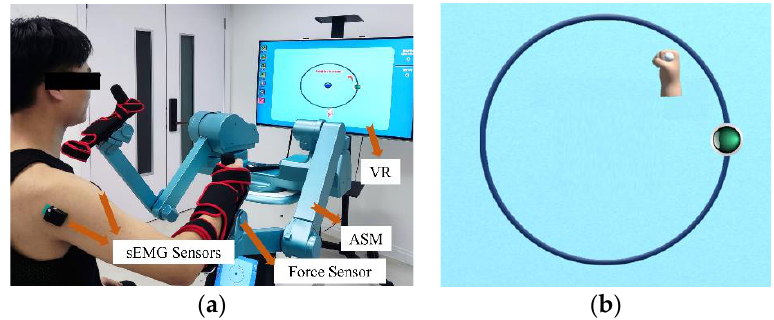
Figure 6. Interaction force 𝐹 𝑒𝑥𝑡 and target velocity 𝑣 𝑟 schematic.